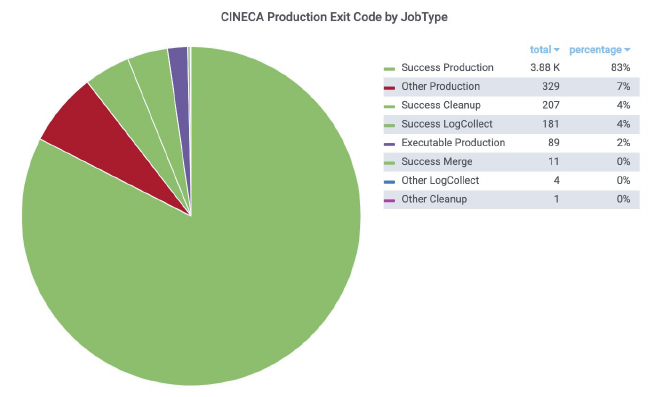
Fig. 4. Exit code for CMS jobs running at ​